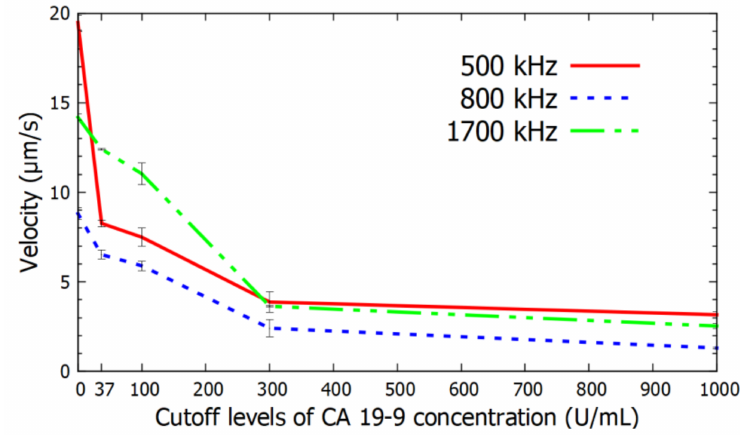
Figure 6. Variation of the drift velocity due to negative DEP with the cut off levels of concentration of CA 19-9 for the frequency range at 500 kHz, 800 kHz, and 1700